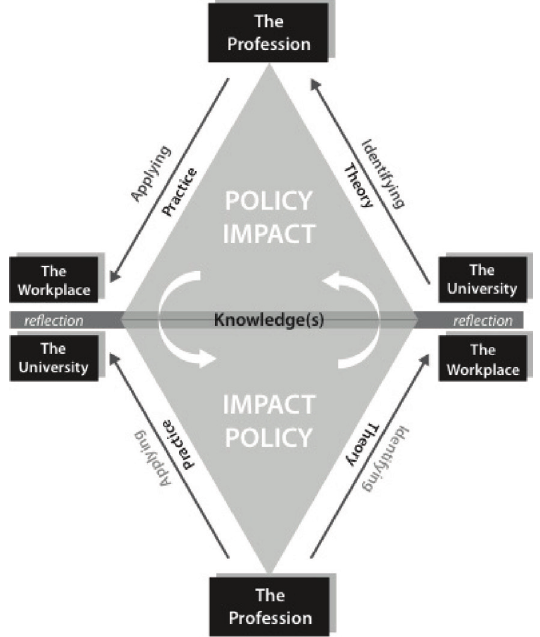
Figure 3: A reflective representation on the being and doing of a professional doctorate and researching professionals’ reflexive practice